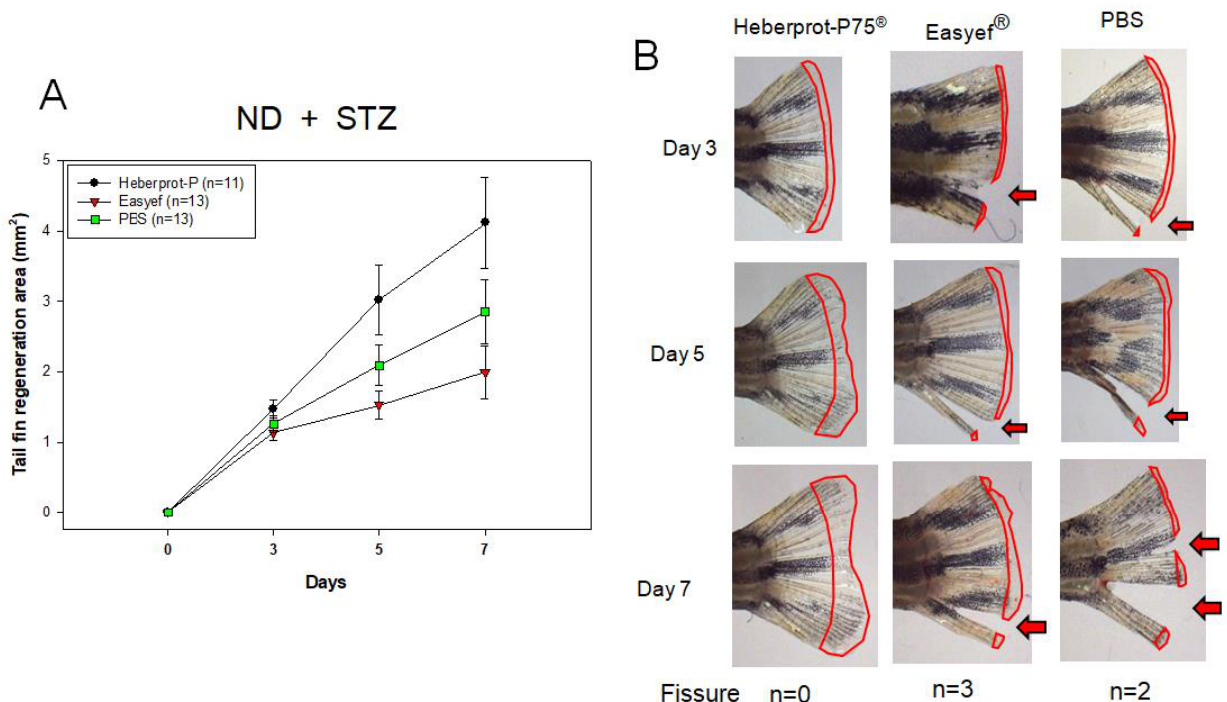
Figure 6. Comparison of tissue regeneration speed ( A ) and morphology ( B ) in the tail fin area under diabetic conditions and ND consumption over seven days. The red arrow indicated the fissure of the tail. At the bottom of the photos, n indicates the number of zebrafish that showed fissure of the tail fin on day 7. ND, normal diet.